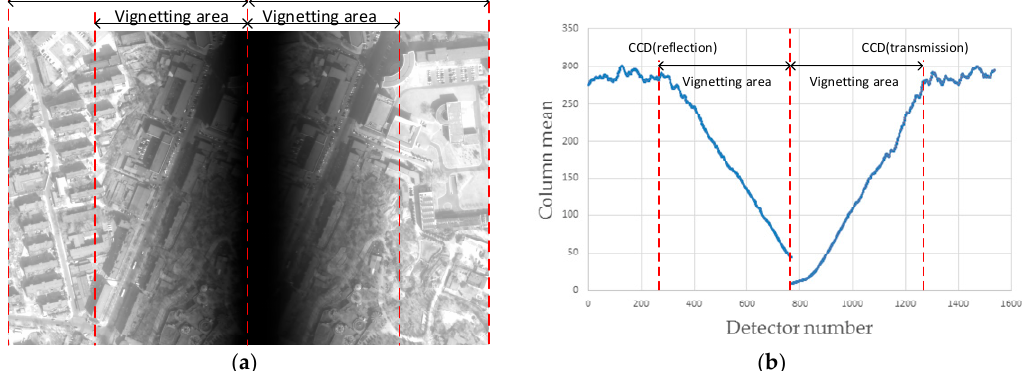
Figure 1. The impact of vignetting on image quality. ( a ) The raw data using the optical butting system; ( b ) the column mean of the raw data show in ( a ).